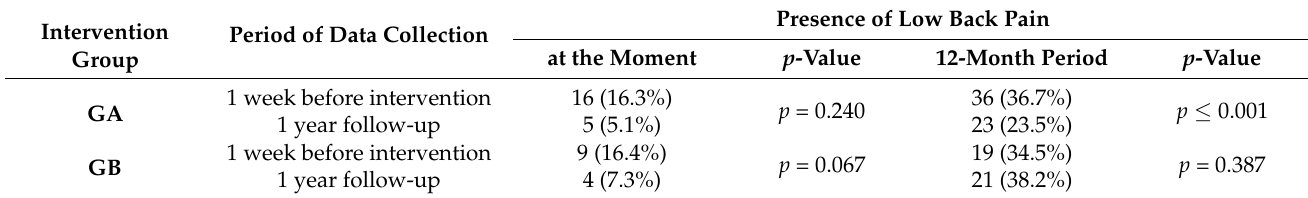
Table 5. Prevalence of low back pain before and after the intervention